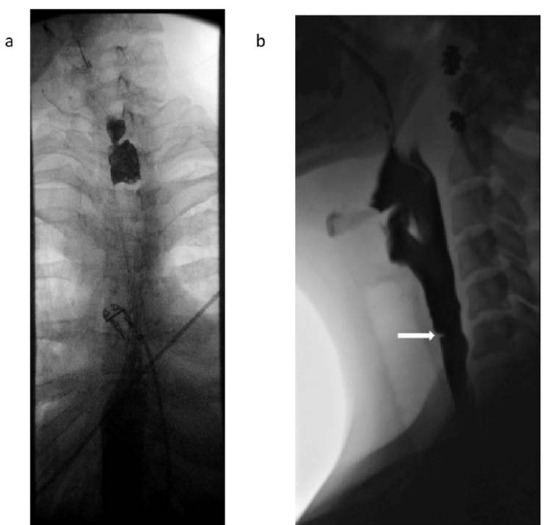
Figure 1. ( a ): Barium swallow from patient 2 showing proximal esophageal narrowing at level of C6 ‐